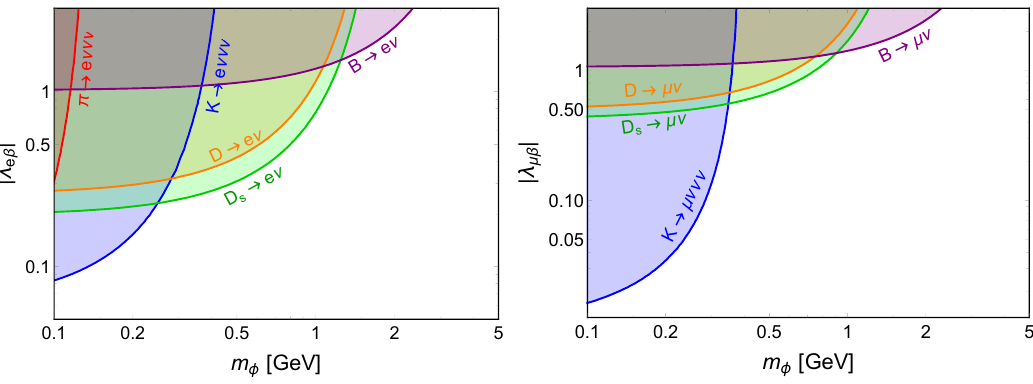
Figure 2 . Limits on j (cid:21) e(cid:12) j (left panel) and j (cid:21) (cid:22)(cid:12) j (right panel) with (cid:12) = e; (cid:22); (cid:28) from current-charged meson decay data in table 1. All the shaded regions are